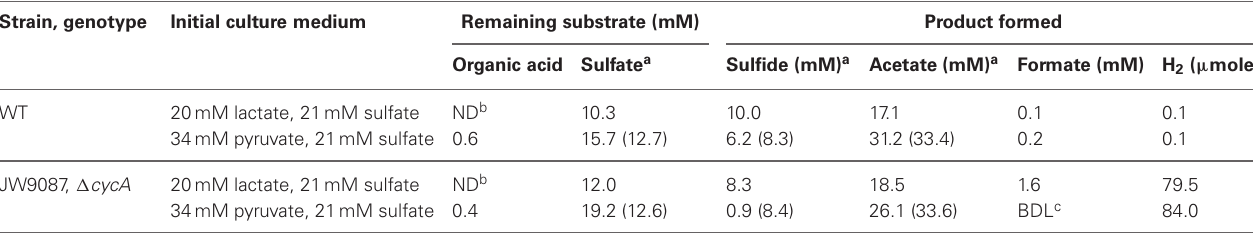
FIGURE 2 | Growth (left) and cell specific sulfate reduction rate (csSRR) (right) of wild-type Desulfovibrio vulgaris Hildenborough and CycA mutant grown on lactate (upper) and pyruvate (lower). Table 2 | Utilization of substrates and compounds produced by wild-type Desulfovibrio vulgaris Hildenborough and CycA mutant at the end of batch culture